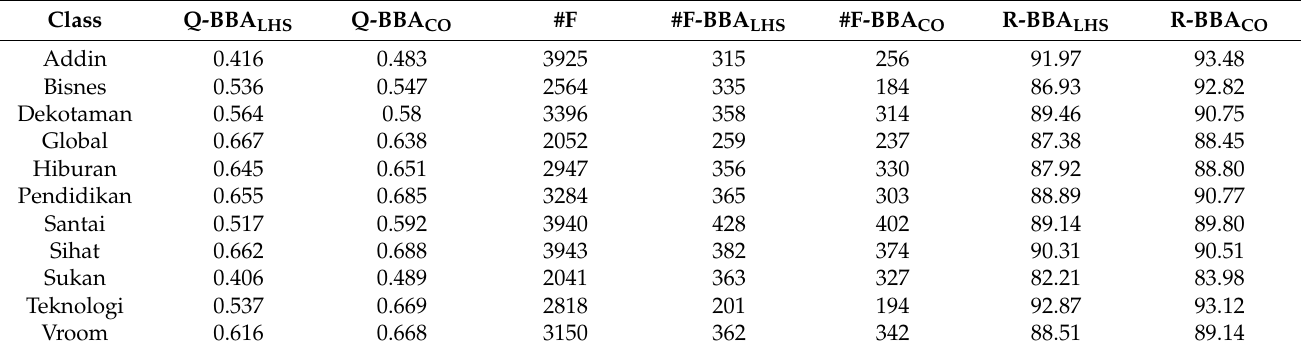
Table 17. Characteristics of the selected feature sets in Harian Metro dataset, where Q indicates the quality of feature set, #F indicates to number of features, R indicates reduction rate (%).